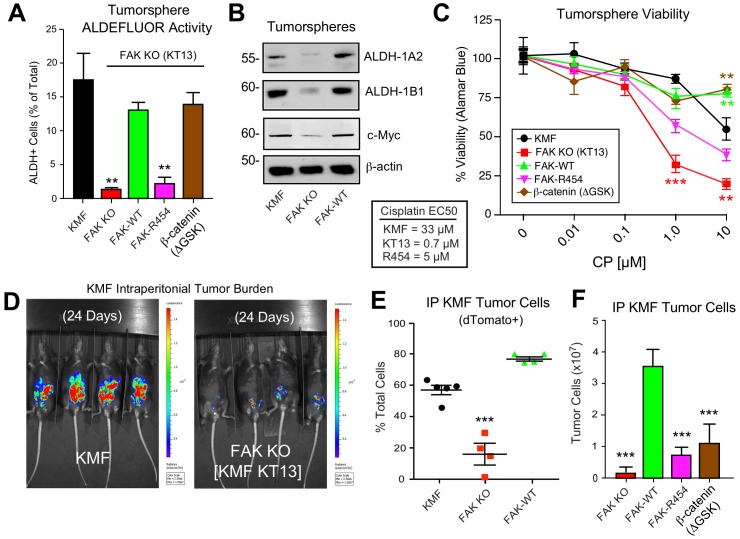
Intrinsic FAK activity supports ALDFLUOR activity, CP resistance, and is essential for KMF tumor growth.(A) ALDEFLUOR activity of KMF, KT13 FAK KO, or the indicated reconstituted cells in PromoCell after 5 days. Values are means (± SEM **p<0.01, ***p<0.001, one-way ANOVA with a Tukey’s multiple comparisons test) of four independent experiments. (B) Immunoblotting for ALDH-1A2, ALDH-1B1, Myc, and actin in the indicated cell lysates. (C) Viability (Alamar Blue) of KMF (black circles), KT13 FAK KO (red squares), GFP-FAK WT (green triangle), GFP-FAK R454 (magenta triangle), and β-catenin ΔGSK (brown diamond) expressing cells treated with increasing CP concentrations for 5 days. Values are means (± SEM, **, p<0.01, ***p<0.001, two-way ANOVA with a Bonferroni’s multiple comparisons test) from three independent experiments. Lower, EC50 values were determined independently and using Prism. (D) IVIS imaging of C57Bl/6 mice with dTomato+ and luciferase-expressing KMF or KT13 FAK KO cells at experimental Day 24. (E) Flow cytometry analyses of peritoneal wash collected dTomato+ cells at Day 28 of mice bearing KMF (black), KT13 FAK KO (red), and FAK KO re-expressing FAK WT (green) cells. Values are means expressed as percent of total cells in peritoneal wash (± SEM, ***p<0.001, one-way ANOVA). (F) Intraperitoneal (IP) tumor growth of KT13 FAK KO (red), GFP-FAK-WT (green), GFP-FAK-R454 (magenta), or β-catenin ΔGSK (brown) expressing cells. Values are means of CD45-negative tumor cells determined by flow cytometry (± SD, ***p<0.001, one-way ANOVA).